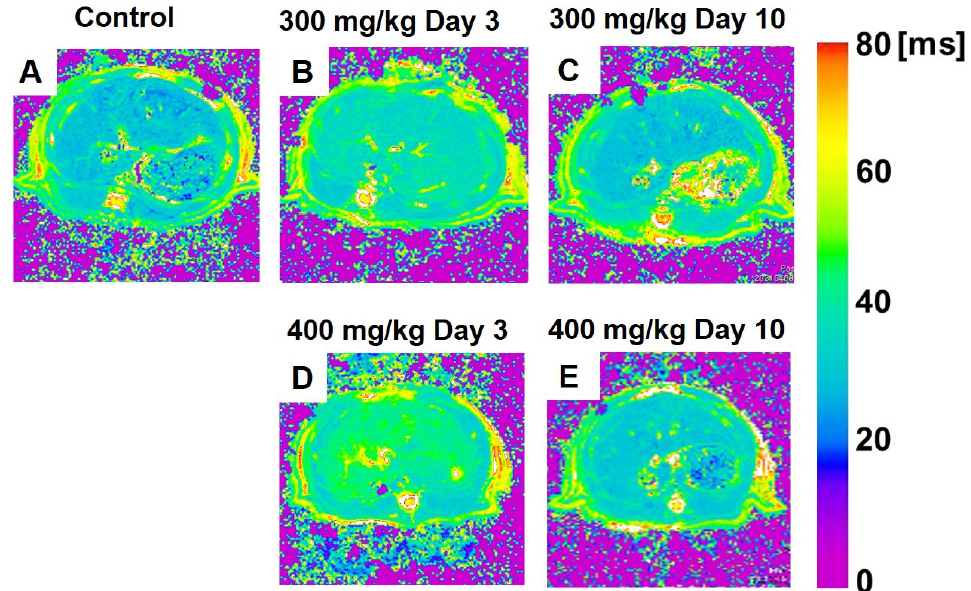
Figure 1. ( A – E ) Color-coded magnetic resonance liver T 1 ρ maps showing representative results in the control ( A ), 300 mg/kg TAA injection ( B , C ), and 400 mg/kg TAA injection ( D , E ) models. TAA, thioacetamide.